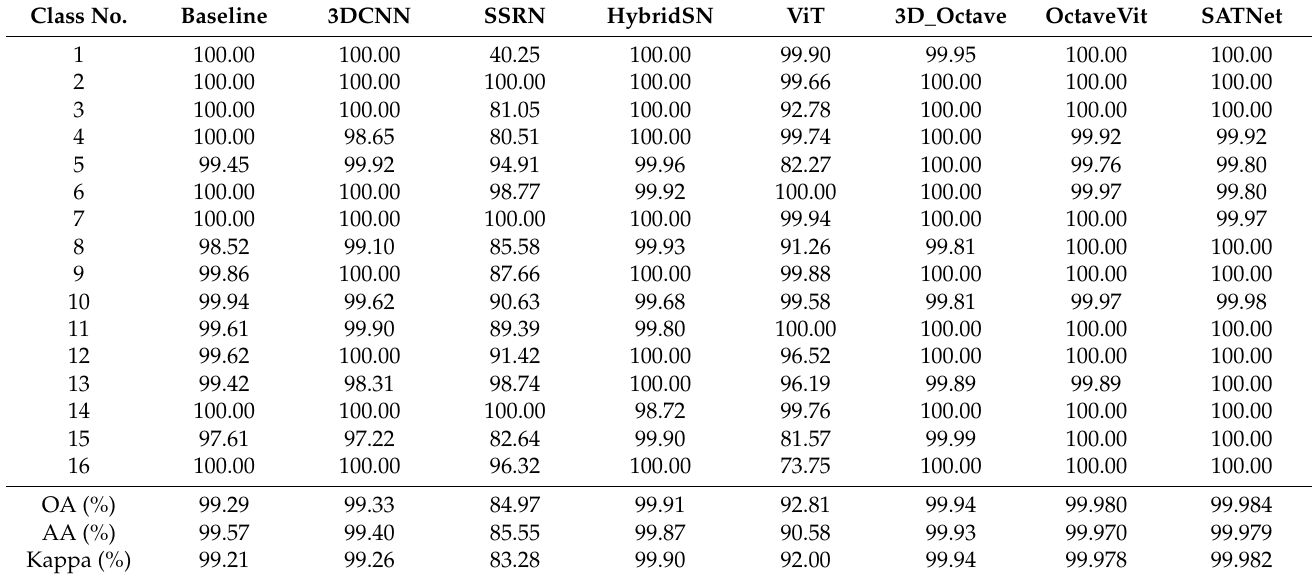
Table 8. Test accuracy with different preprocessing methods on the SA